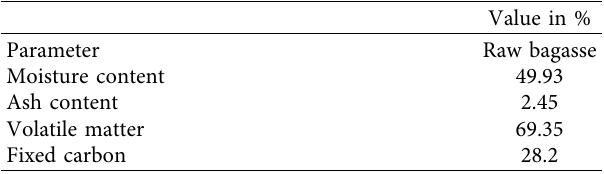
Table 1: Summary of proximate analysis results.